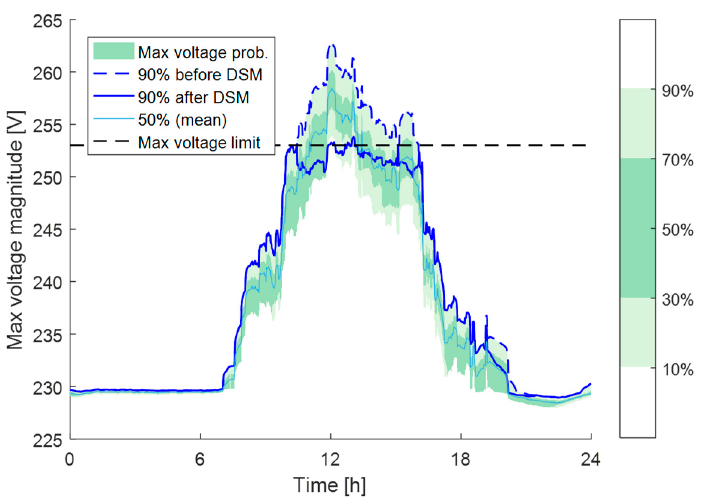
Figure 6. 90% probability maximum voltage magnitudes over time.